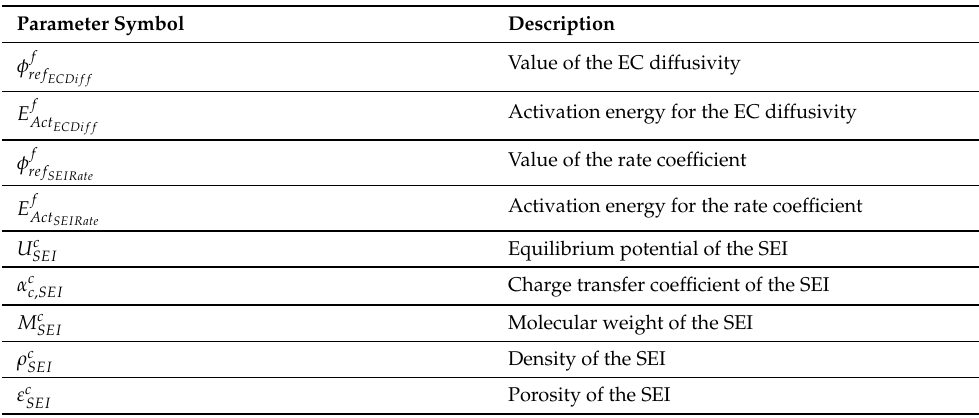
Table 7. Description of the parameters from Table